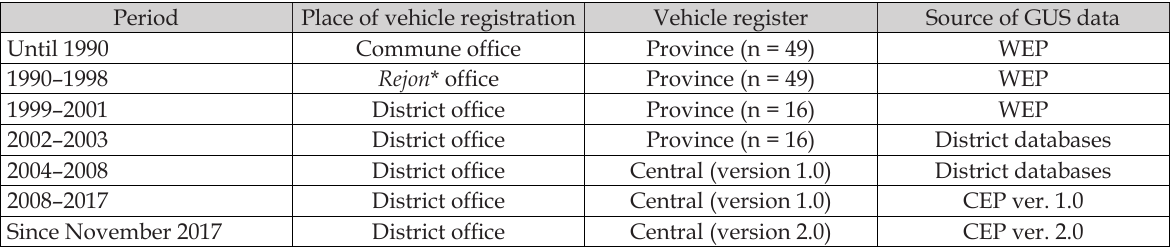
Table 1. Authorities responsible for collecting and sharing motorisation statistics in